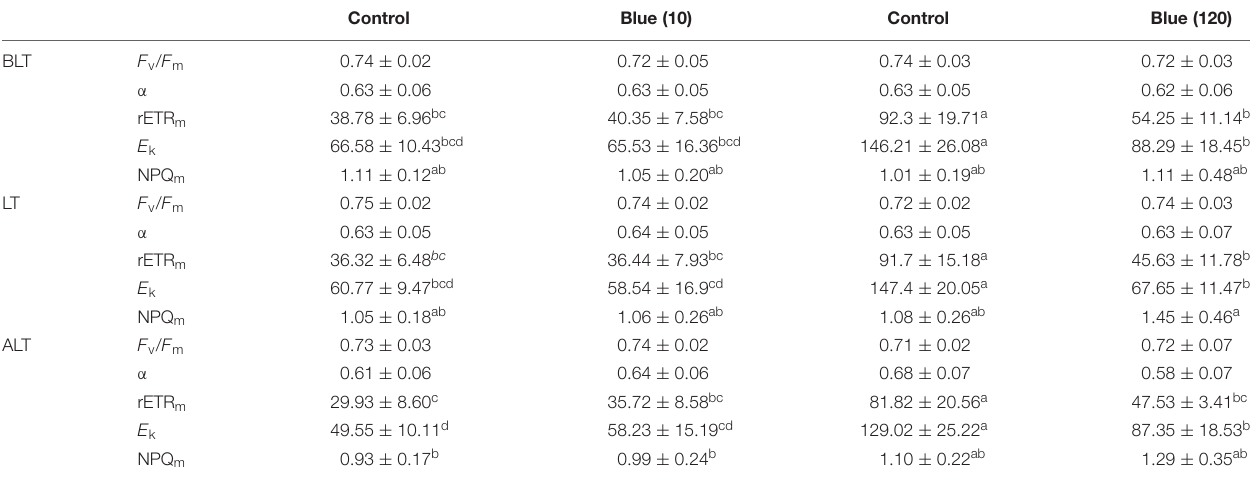
TABLE 1 | Photosynthetic parameters of microphytobenthos (MPB) exposed to blue (465 nm) light conditions (the blue 10 and 120 µ mol photon m − 2 s − 1 intensities between brackets) and their respective control light conditions: because the two blue light exposures could not be performed simultaneously, it was necessary to perform measurements under control light conditions independently for each of